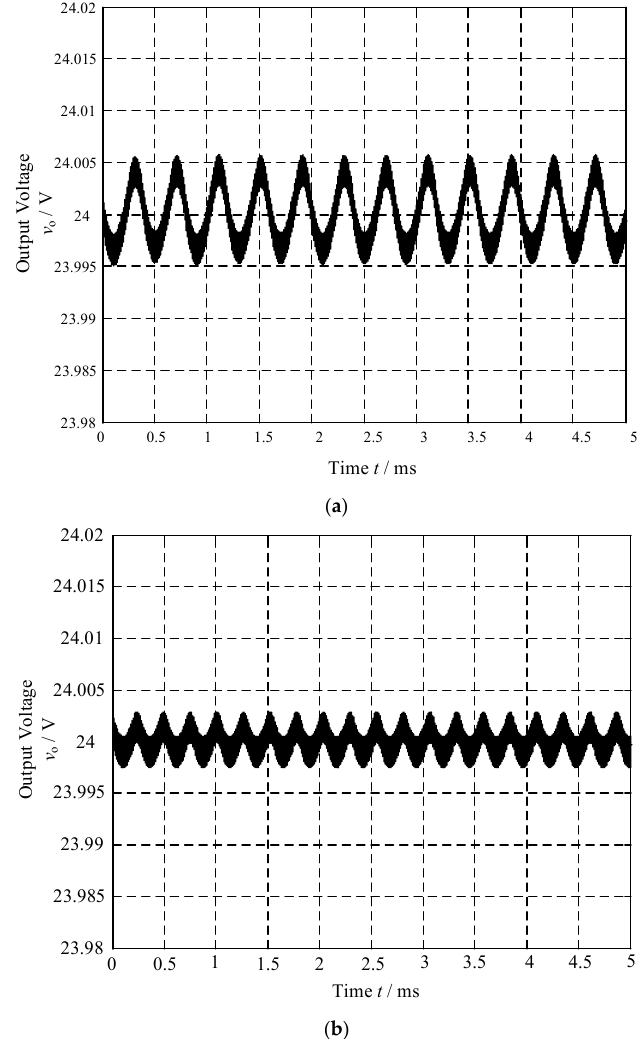
Figure 6. Simulation waveforms of output voltage for ( a ) a single-loop controller and ( b ) a double- loop